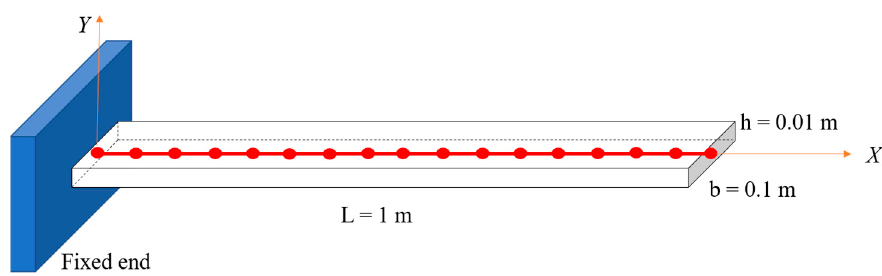
Figure 4. Cantilever beam.